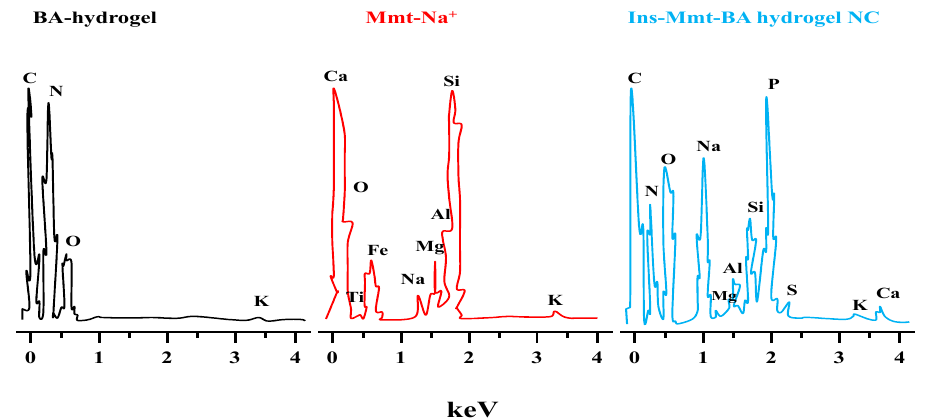
16 of 28 Figure 5. SEM photomicrographs of unloaded BA hydrogel ( a , b ) and Ins-Mmt-BA hydrogel NC ( c , d ). 3.8. Energy Dispersive X-ray Spectroscopic Analysis (EDS) The comparative analysis of the EDS spectrum of unloaded BA-hydrogel, Mmt-Na + clay and Ins-Mmt-BA hydrogel NC was performed using EDS spectroscopy (Figure 6) to confirm the loading of Ins-Mmt clay into the BA hydrogel to form an Ins-Mmt-BA hydro- gel NC. It can be observed (Table 3) that the elemental composition of unloaded BA hy- drogel was C (57.32%), N (9.14%), O (33.23%) and K (0.31%). While for Mmt-Na + , the ele- mental composition was O (55.81%), Mg (0.98%), Al (6.18%), Na (1.08%), Si (34.73%), K (0.64%), Ca (0.20%), Ti (0.25%) and Fe (1.22%). In the case of Ins-Mmt-BA hydrogel NCs,